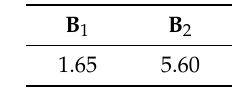
Table 2. Coefficients in Equation